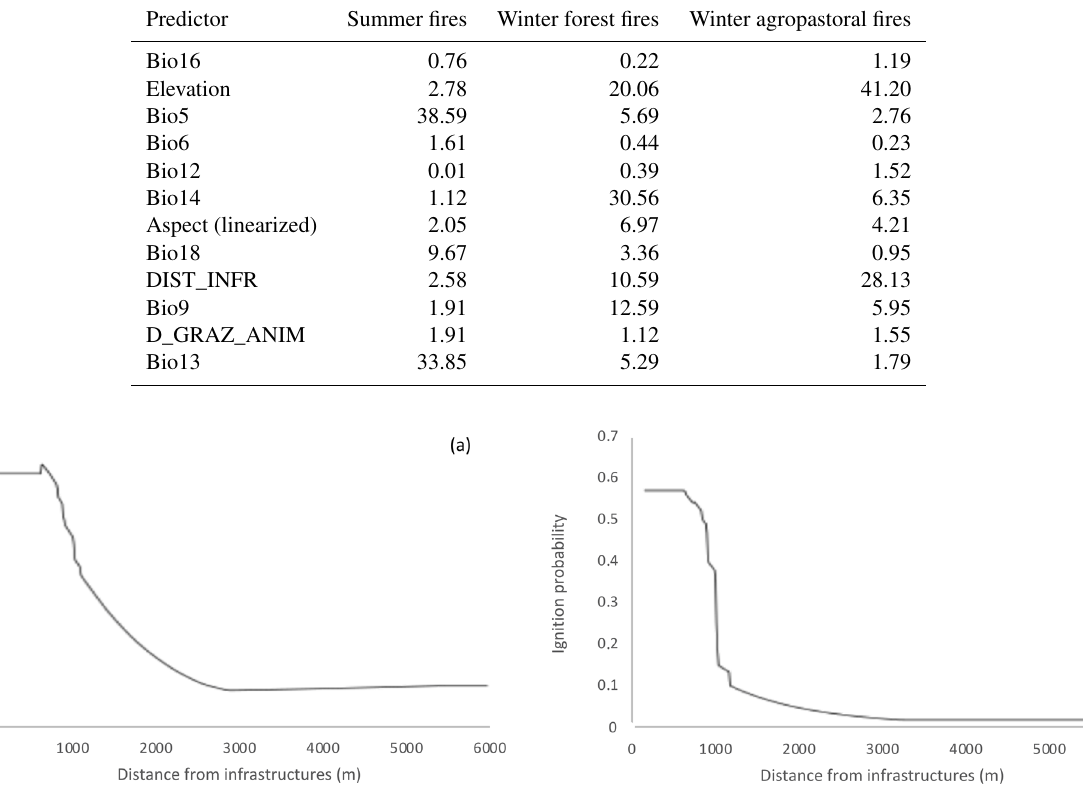
Figure 7. MaxEnt response curve for the effect of distance from infrastructures on ignition probability in winter forest (a) and agropastoral fires (b)